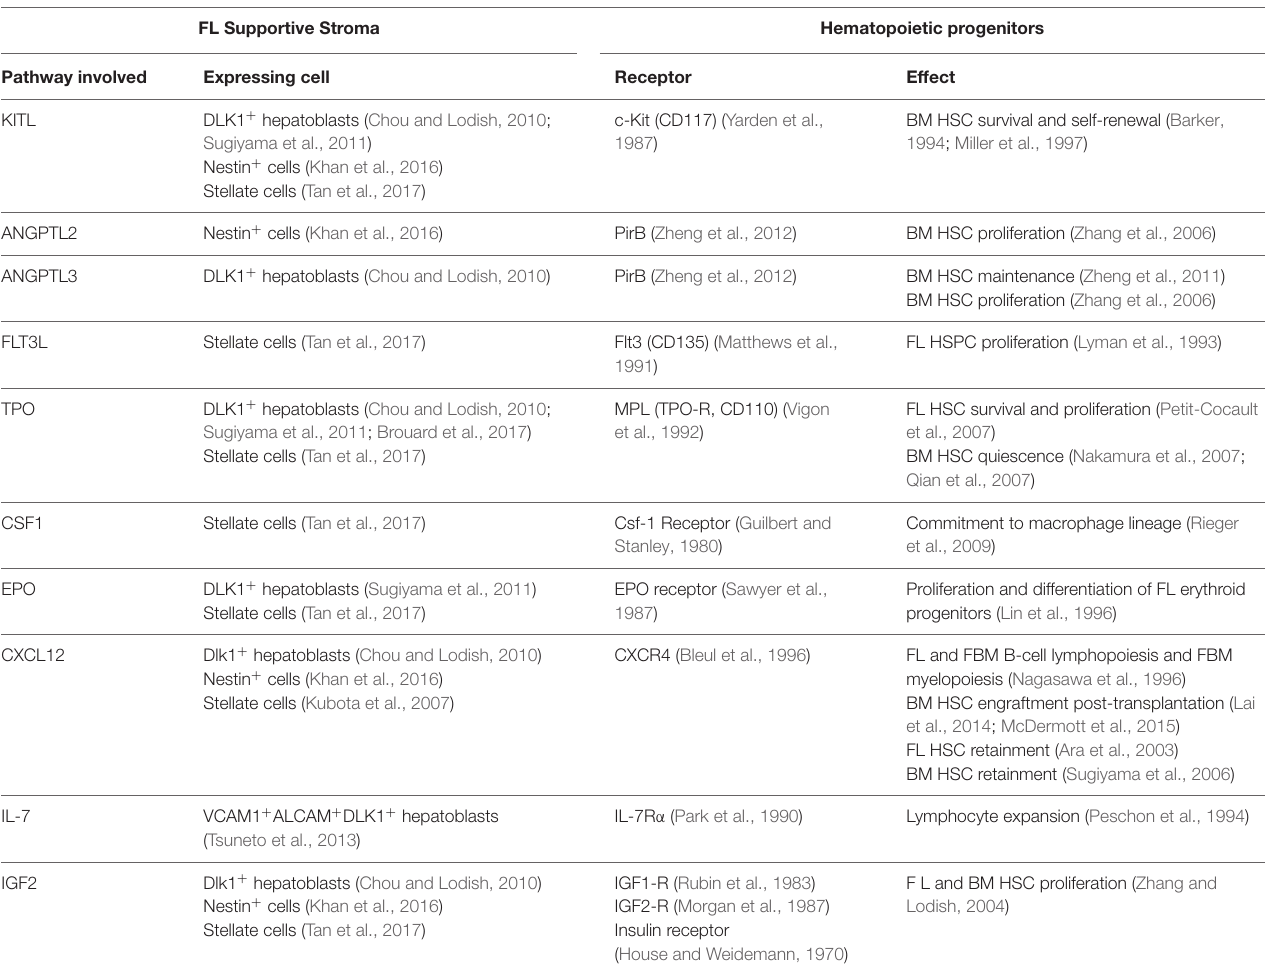
TABLE 2 | Cytokine signaling in fetal